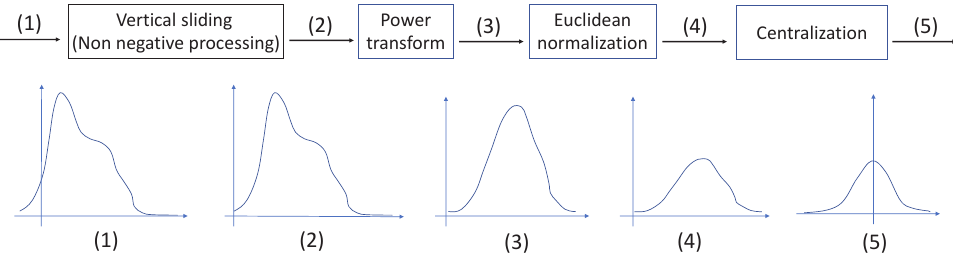
Figure 10. The schematic diagram of the GC module. (1) The histogram of the raw feature distribution, (2) The histogram after vertical sliding. (3) The histogram after power transform. (4) The histogram after normalization. (5) The histogram after